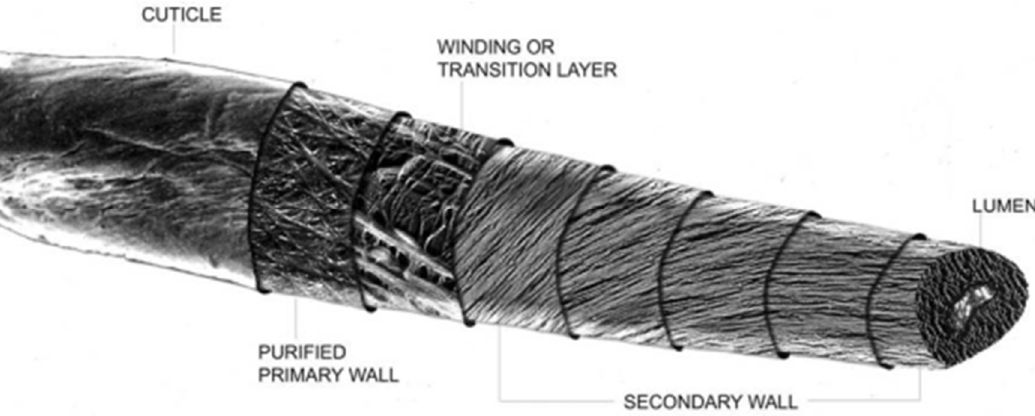
Figure 1. A montage of cotton fiber sections constructed from individual electron micrographs (TEMs) and scanning micrographs (SEMs) of the fiber. Gives an overview of the layered structures of the fiber. The fiber cuticle, primary and secondary cell walls have been shown at different magnifications, to better visualize fibrillary structures and fiber layers from the surface to the lumen [3].